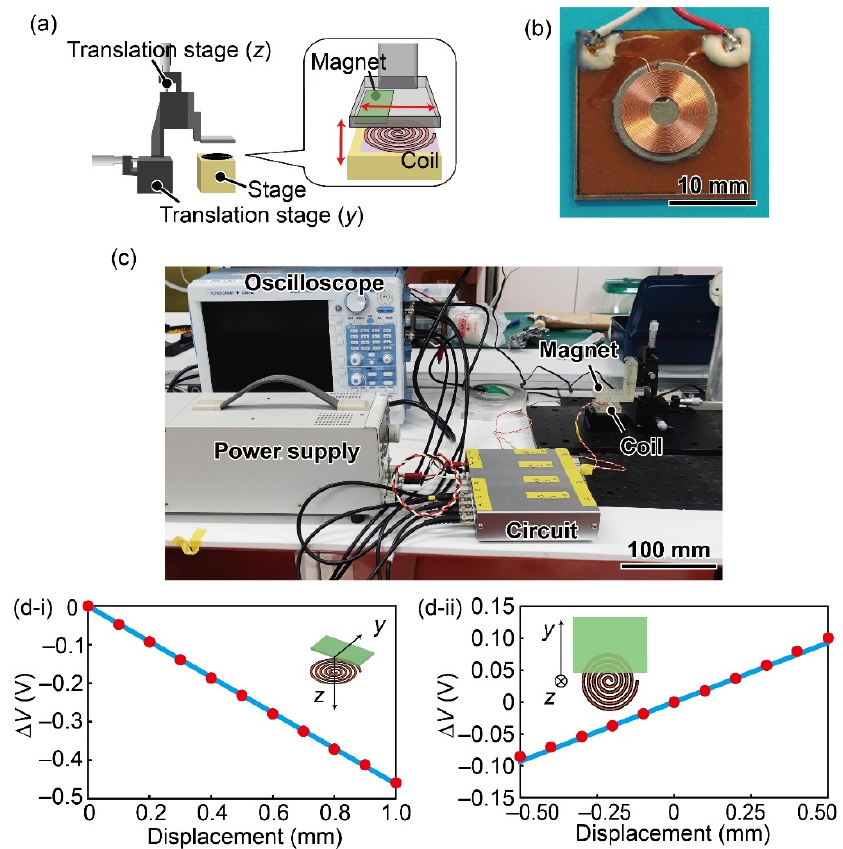
Figure 5. ( a ) Schematic image of the experiment to evaluate the displacement sensor. ( b ) Photograph of the planar coil. ( c ) Photograph of the experimental setup. Relationship between the sensor output and the displacement in the ( d-i ) z-direction and ( d-ii ) y-direction.